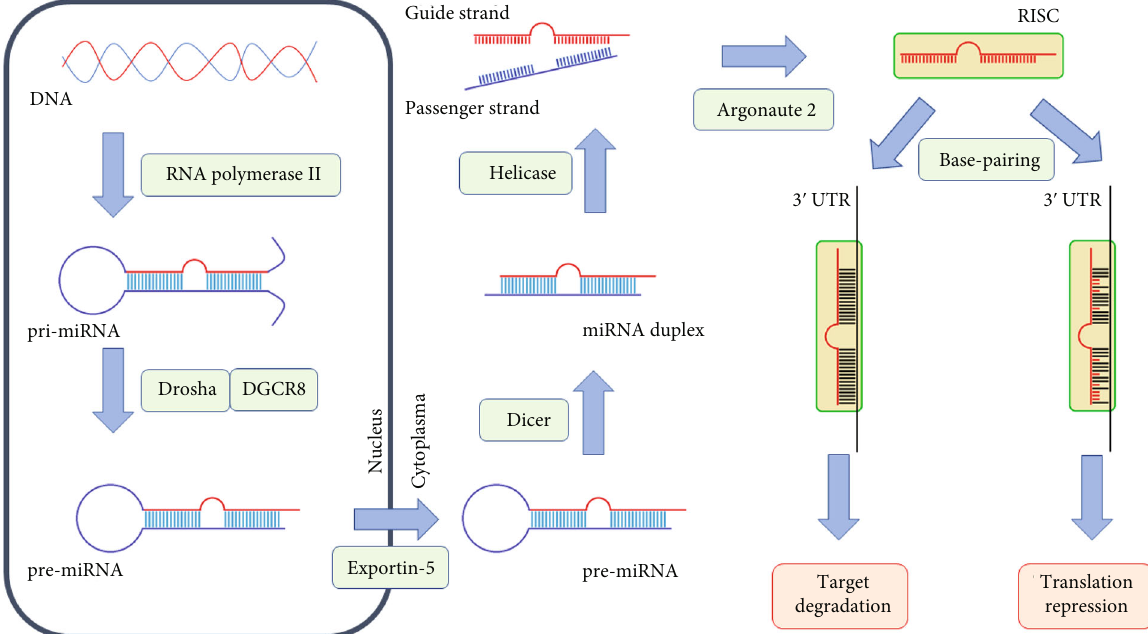
Figure 1: Biogenesis and functioning of miRNA. The fi gure illustrates the following steps: (a) endonuclear synthesis of the primary double- stranded miRNA transcript (pri-miRNA) of hundreds to thousands of nucleotides in length, mostly by RNA polymerase II; (b) cleavage of pri-miRNA by Drosha endonuclease accompanied by DiGeorge syndrome critical region protein 8 (DGCR8), resulting in formation of 60 to 70 nucleotide long pre-miRNA; (c) export of pre-miRNA from the nucleus into the cytoplasm by Exportin-5 coacting with GTP- binding nuclear protein Ran (Ran-GTP); (d) cleavage of pre-miRNA by Dicer into an asymmetric miRNA duplex containing guide and passenger strand of about 22 nucleotides in length; (e) unwinding the duplex by helicase and release of the passenger miRNA with its subsequent degradation; (f) loading the guide strand by Argonaute 2 into the RNA-induced silencing complex (RISC); (g) binding RISC (containing mature miRNA) to 3 ′ untranslated region (3 ′ UTR) of target mRNA; (h) translational repression or target degradation depending on the partial or full complementarity of base-pairing. Based on [60 –